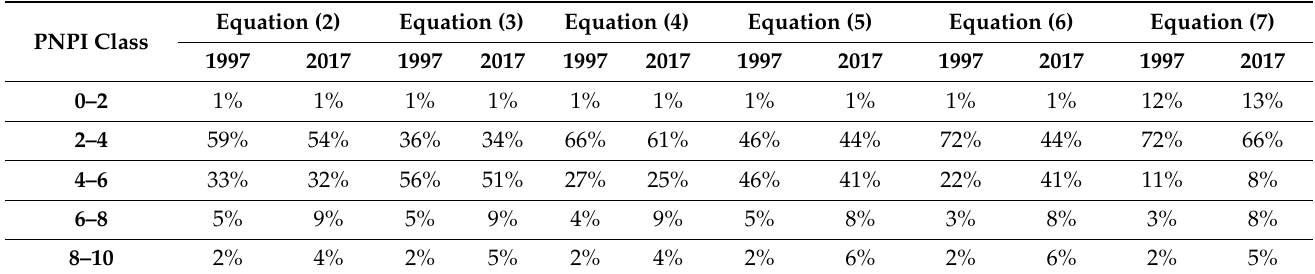
Table 6. Catchment area covered (percentage) by the different non-point pollution index (PNPI) classes calculated from six equations; LCI*4+RoI*4+DI*2 (Equation (2)), LCI*5+RoI*2+DI*3 (Equation (3)), LCI*5+RoI*3+DI*2 (Equation